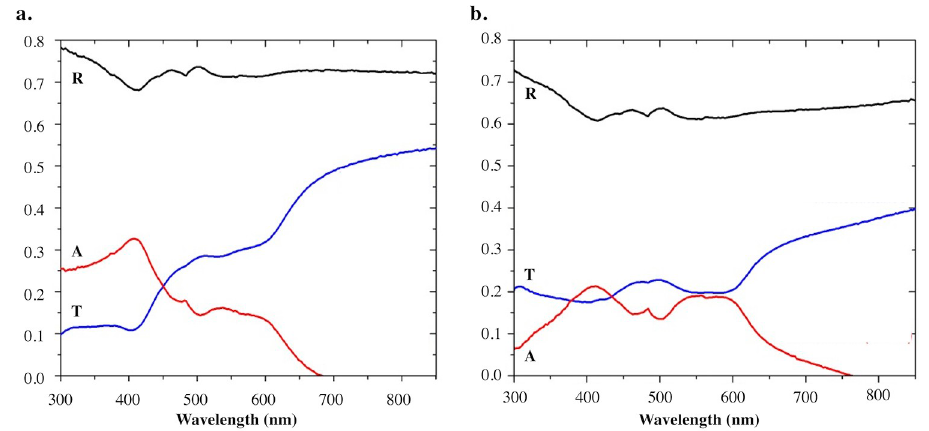
Fig 6. Reflectance and absorbance of the M . pelagios white band and tongue denticles measured by spectrophotometry. Reflectance (R) and Absorbance (A) measured for (a) the white band and (b) the tongue denticles. Transmittance (T) was evaluated using the following relationship A =